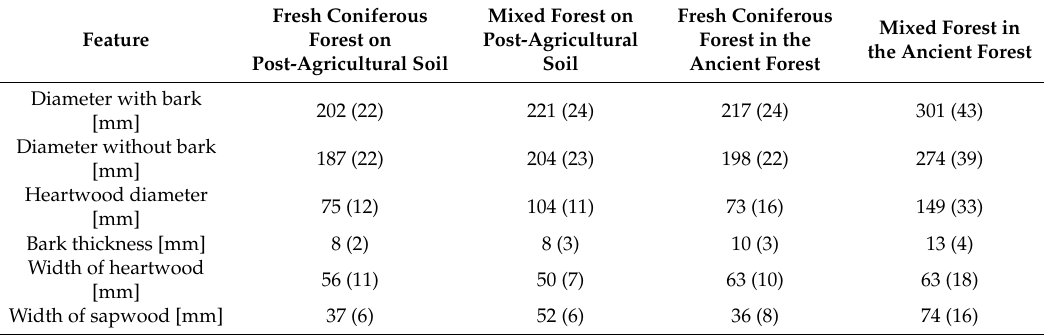
Table 2. Dimensional features of pine trunks at breast height diameter, dbh (standard deviation is given in parentheses).